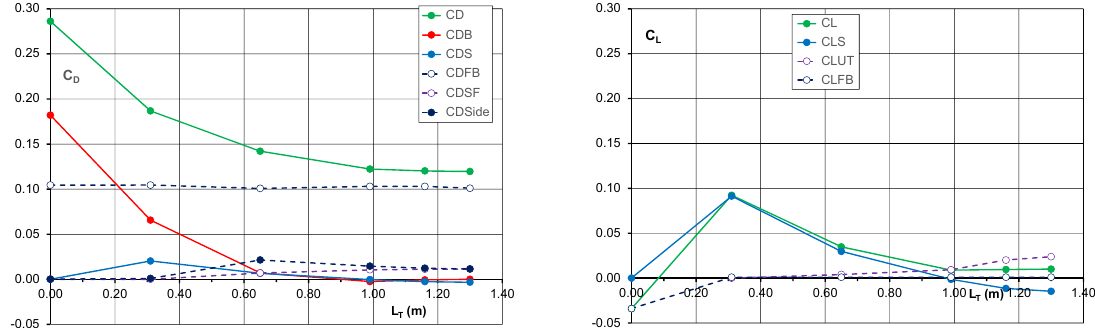
Figure 12. Suggested breakdown of drag, ( left ), and lift, ( right ), coefficients for 3D taper case. For the drag breakdown, Figure 12 (left), the slant surface drag coefficient, C DS , is derived directly from the slant surface lift. The base pressure coefficient is assumed to vary as shown in Figure 11, based on the base area ratio, and the base drag coefficient, C DB , is then the product of base pressure coefficient and base area. The skin friction drag coefficient, C DSF , is modified based on the change in surface area and the forebody drag is assumed to be the same as the 2D case. The remaining drag component on the tapered side surfaces, C DSide , is then given by the difference between the total drag coefficient, C D , and the sum of the base, slant, forebody and skin friction components.